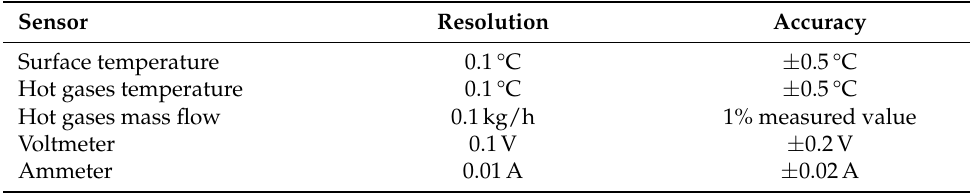
Figure 11. Sensors and probes distribution along the thermoelectric generators. Table 1. Resolution and accuracy of the measurement